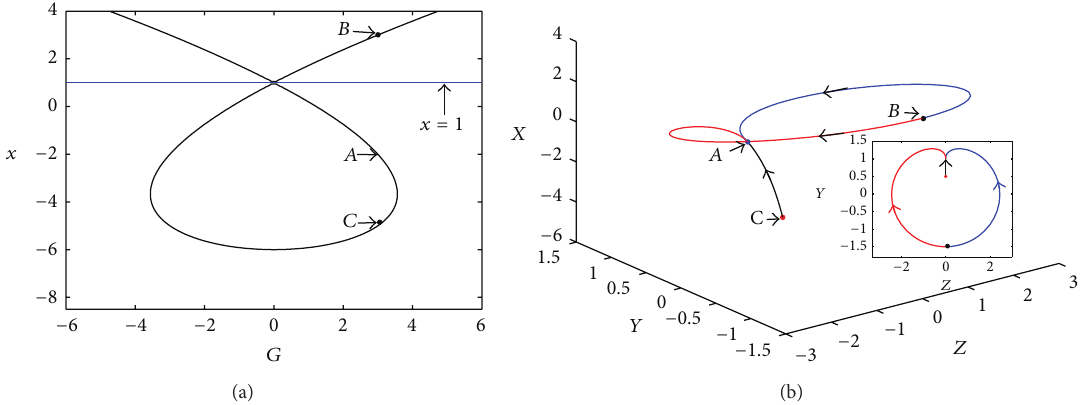
Figure 2: (a) The curve of 𝑎(𝐹 − 𝑥)(1 − 𝑥) 2 = 𝐺 2 . (b) Phase plane of of system (1) with the parameter 𝐺 = 3 .